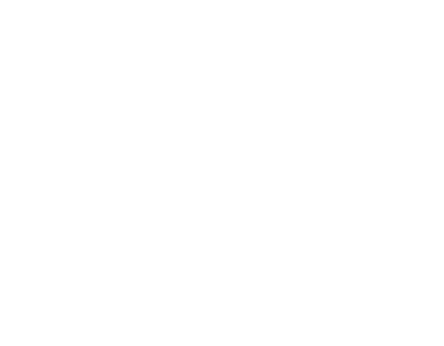
Table 2. The result of keyword search for “Hologram 3D”. Source own study.